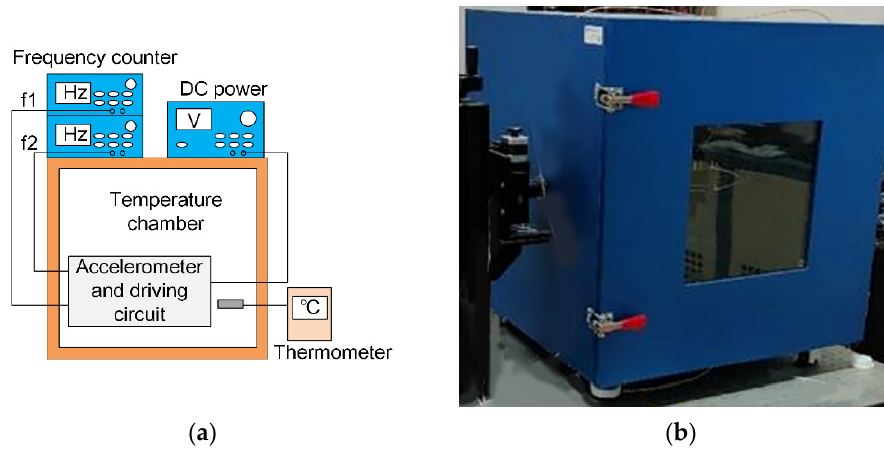
Figure 5. ( a ) The platform for temperature test. ( b ) Temperature chamber.